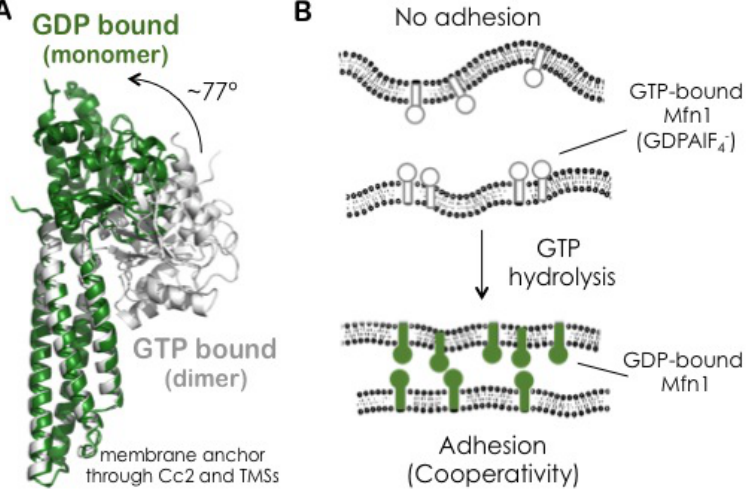
Figure 7. Working model for the role of Mfn1 on the adhesion of lipid membranes. ( A ) Crystal structure of MFN1 construct (without Cc2 and transmembrane domains; pdb 5GOE (green; [17,75]) and pdb 5YEW (grey; [17]). The conformational change of the GTPase domain relative to the first coiled-coil domain HR1 is indicated with an arrow. ( B ) A possible scenario for Mfn1-mediated membrane adhesion. According to the available literature, our data suggest that the Mfn1 proteins resides in a cis -dimer GTP-bound state that is disrupted upon GTP hydrolysis. GTP hydrolysis produces a conformational change from a compact “GTP-bound” cis -dimer to an elongated “GDP-bound” monomeric state [17]. These monomers are now able to interact in trans with other extended proteins GDP-bound Mfn1 proteins from adjacent membranes. Interaction affinity and the adhesion strength is primarily determined by the distance between the adjacent undulating membranes. The formation of trans -dimers limits the local membrane undulations and promotes the formation of additional trans “GDP”-Mfn1 interactions. In this way, the adhesion force depends in a cooperative manner depending on the local protein concentration and the strength of membrane undulation. At low protein coverage, the repulsive membrane undulations prevent membrane adhesion (Top), whereas a high protein coverage leads to a cooperative binding of the lipid bilayer counterparts (Bottom). With our setup, we do not observe any fusion event, therefore we suggest that the complete membrane fusion requires additional factors such as the presence of the